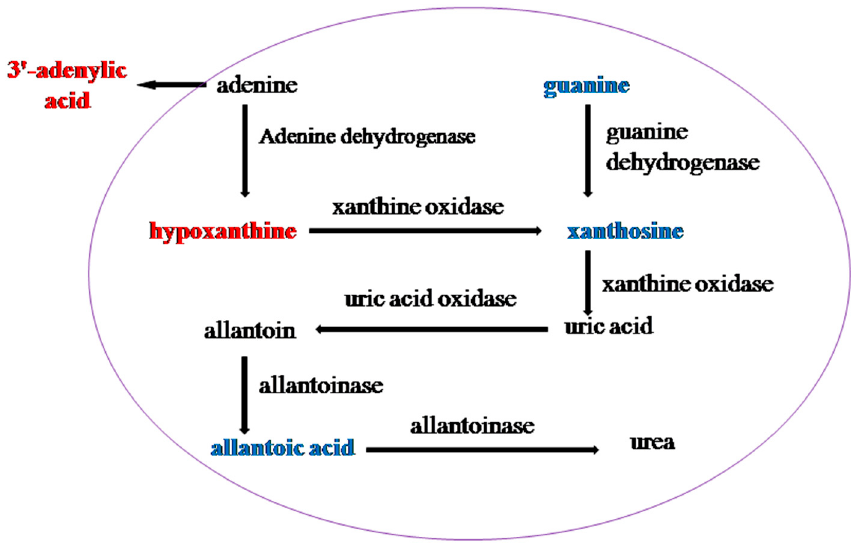
Figure 6. Di ff erential metabolites between T6_F vs. T6_C are located in Purine metabolism. Figure 6. Differential metabolites between T6_F vs. T6_C are located in Purine metabolism. Red Red indicates upregulated in purine metabolism and blue indicates downregulated in indicates upregulated in purine metabolism and blue indicates downregulated in purine metabolism. purine